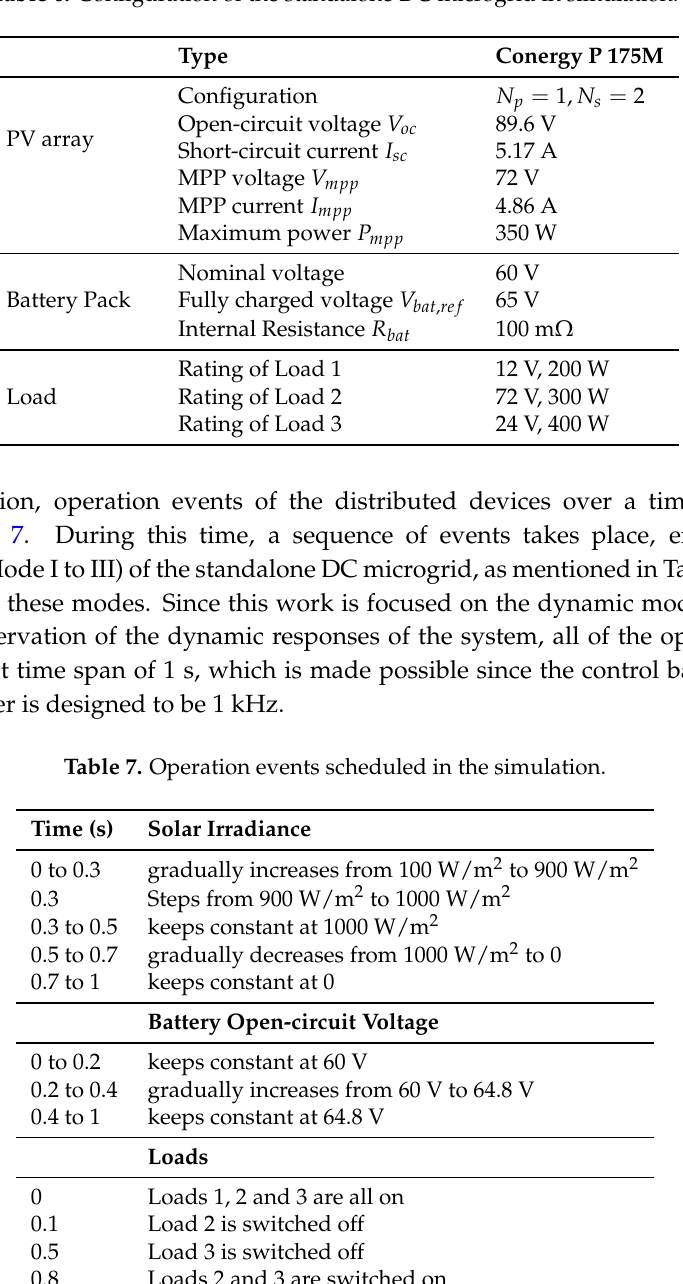
Table 6. Configuration of the standalone DC microgrid in simulation.